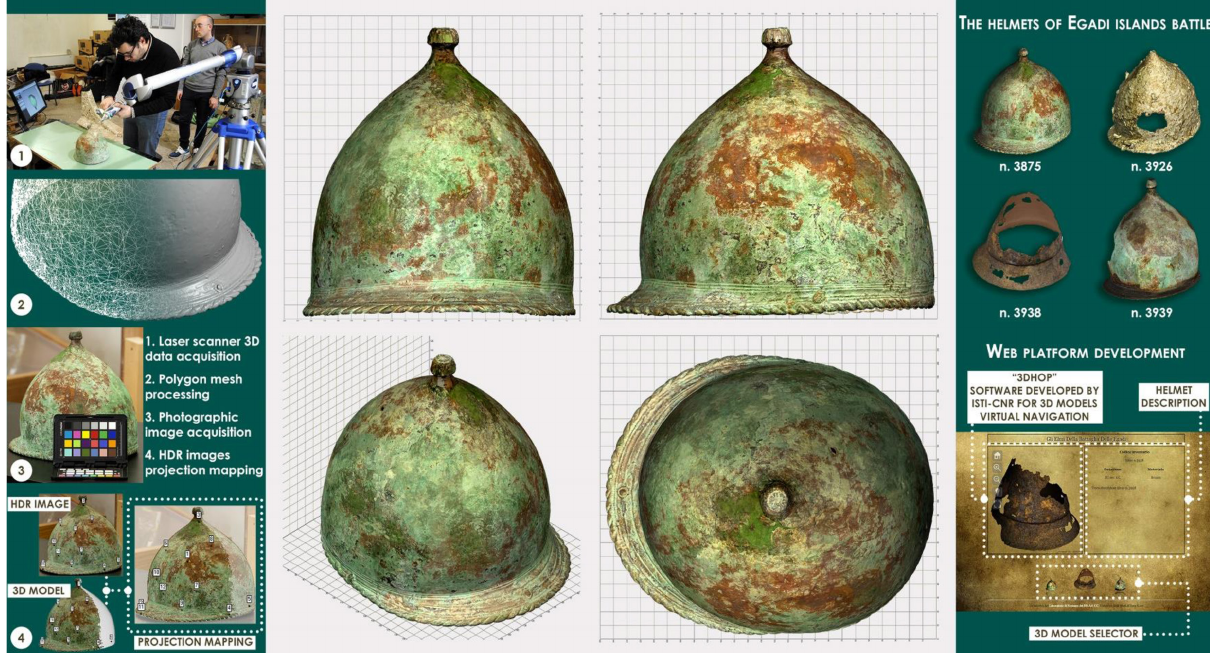
Figure 8. Generation process and 3DHOP platform for the online presentation of the high-resolution 3D